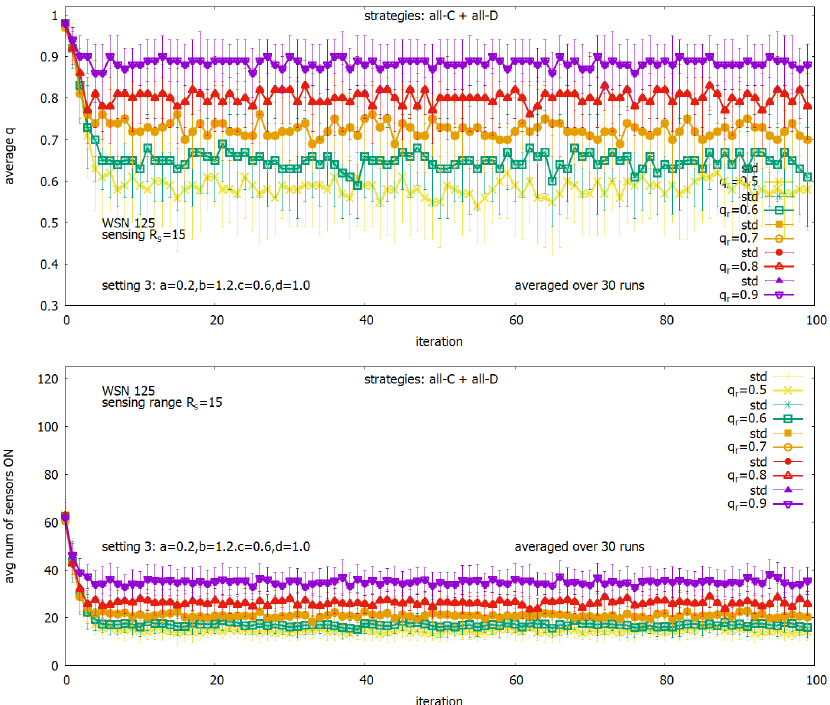
Figure 12. Solutions generated under setting 3 for a range of q r : coverage q ( upper ) and a correspond- ing number of active sensors ( lower